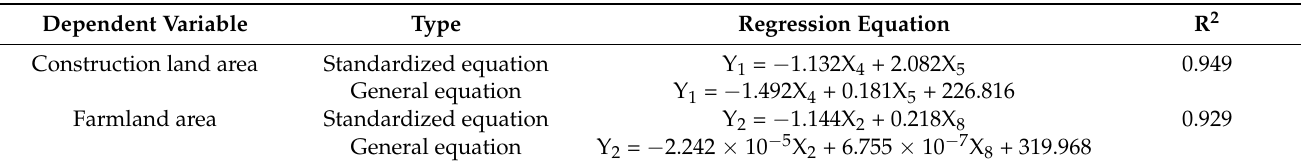
Table 4. Multiple regression